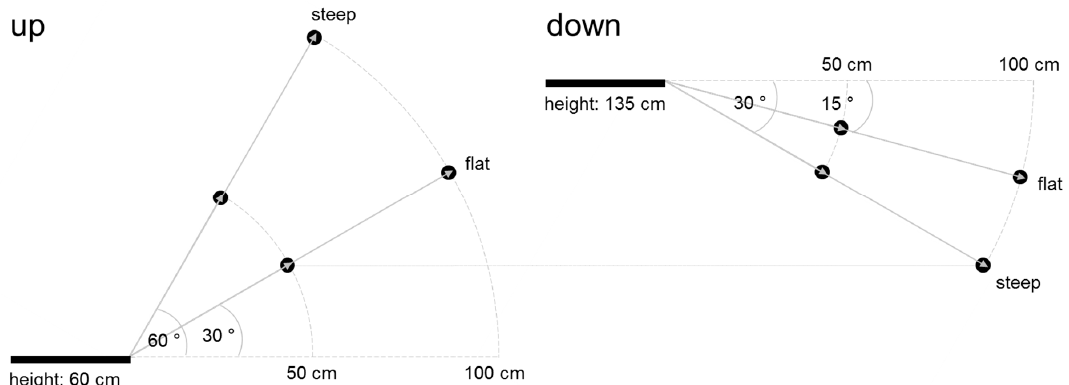
Figure 3. Test conditions based on a 2 × 2 × 2 factorial design combining steep and flat angles, 50 cm and 100 cm distance, and upward and downward jumps. The bar represents the take-off platform at different heights for up and down, whereas the dots show the positioning of the landing perch for all treatment combinations. The landing perch for the condition up/50 cm/flat was installed at the same height as the landing perch for the condition down/100 cm/steep.